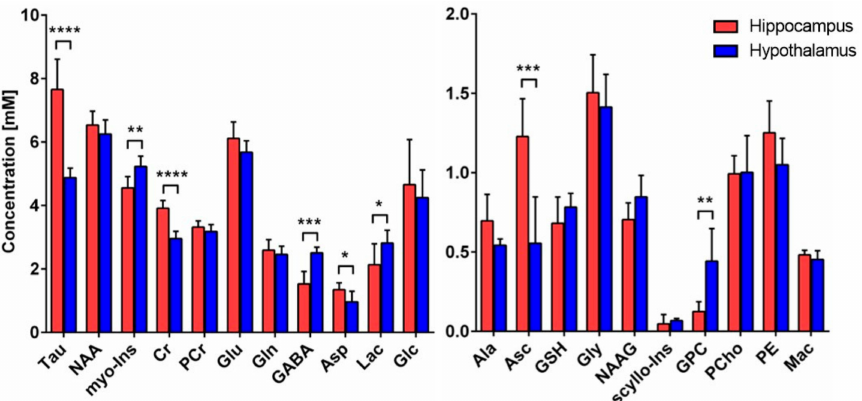
Figure 2. Neurochemical differences between hippocampus and hypothalamus. Neurochemical differences between hippocampus ( n = 8) and hypothalamus ( n = 6) were assessed using Student t